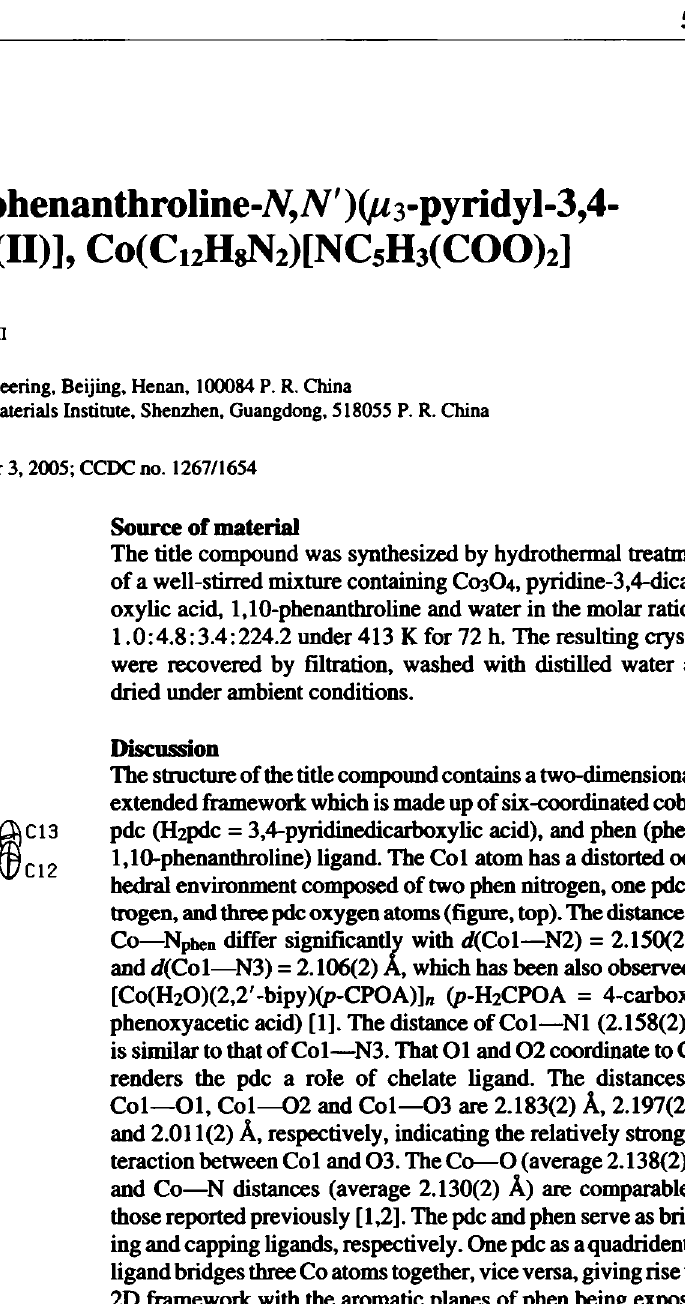
Table 1. Data collection and